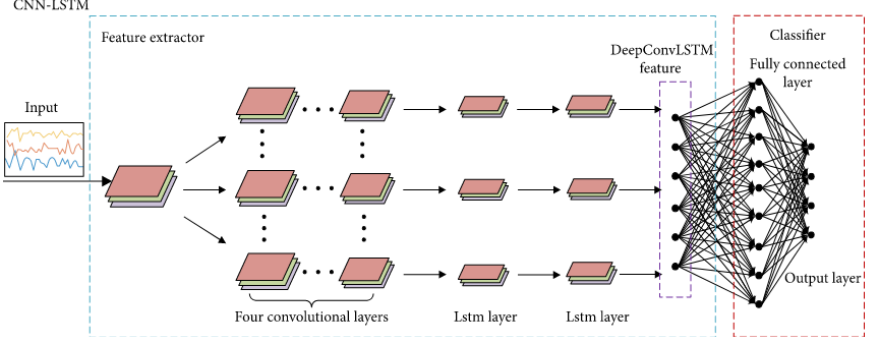
Figure 13. The proposed CNN–LSTM–ELM [103].